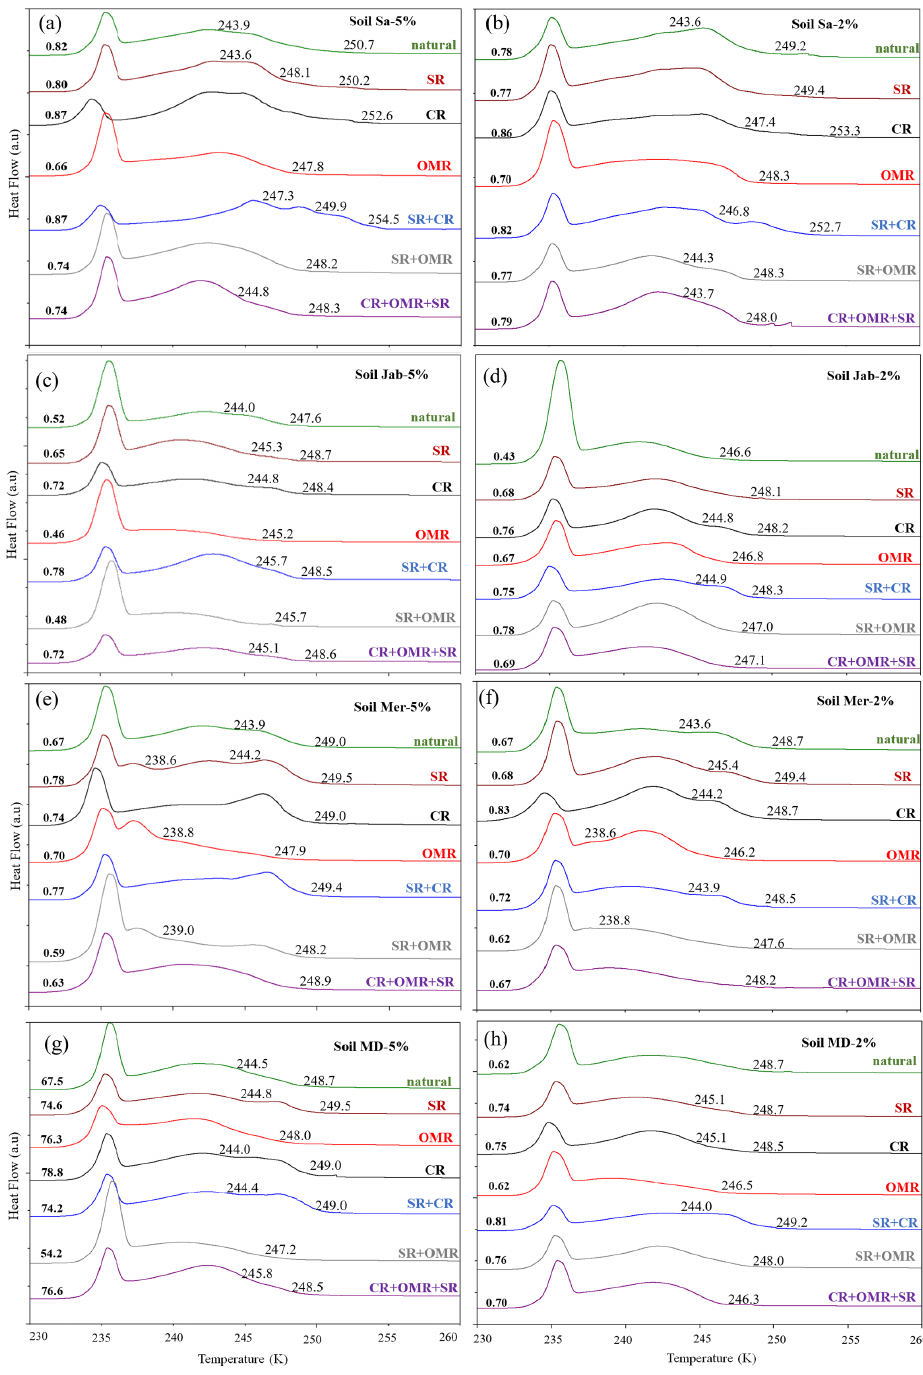
Figure A1. DSC thermograms of treated soil samples with 5wt% (a, c, e, g) and 2wt% (b, d, f, h) concentrations in comparison with the untreated samples. SR: salt removed; CR: carbonate removed; OMR: organic matter removed; SR + CR: salt and carbonate removed; SR + OMR: salt and organic matter removed; SR + CR + OMR: salt, carbonate, and organics removed. T het in Kelvin and F het in fraction are displayed directly on the